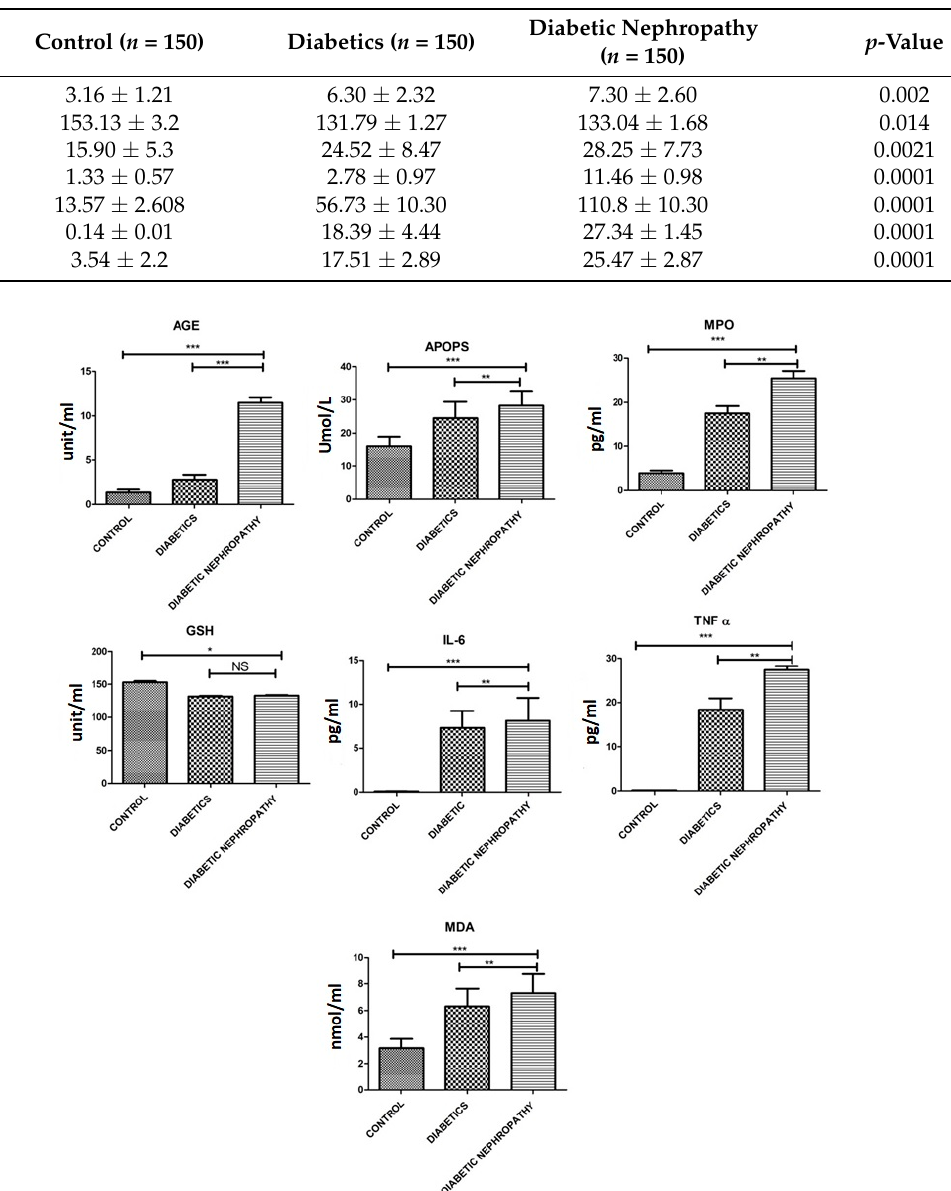
Table 3. Levels of circulating stress markers, inflammatory cytokines in controls, diabetics, and diabetic nephropathy patients.